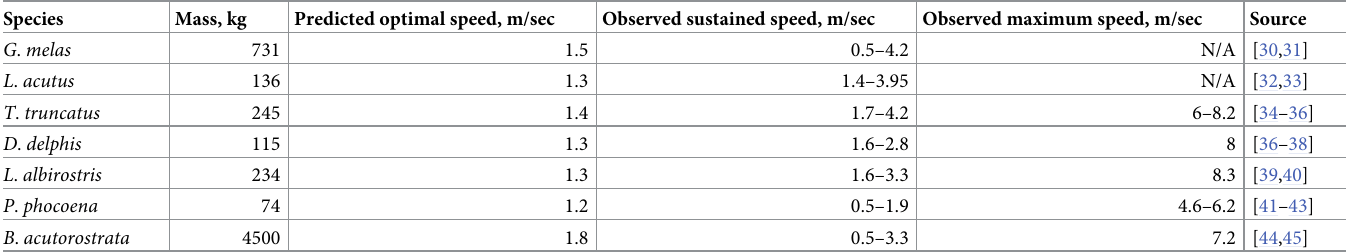
Table 1. Predicted and observed speeds of swimming for the selected species.